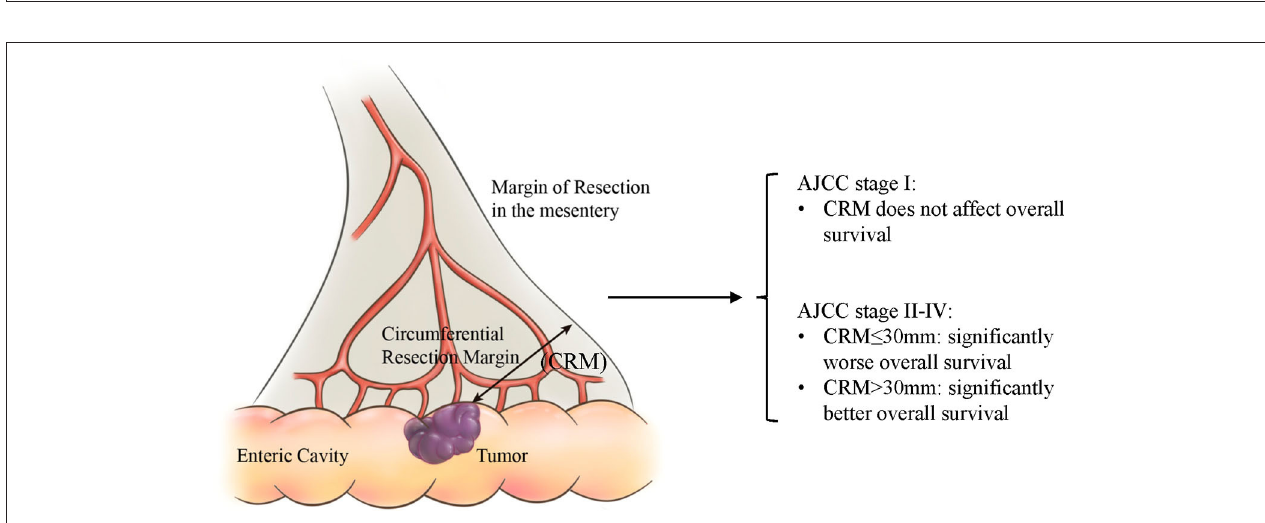
FIGURE 4 | A schematic diagram of CRM in intraperitoneal colon